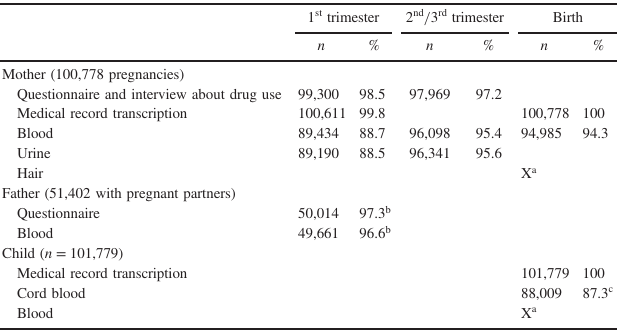
Table 1. The response rates of the mothers, fathers, and children for each survey